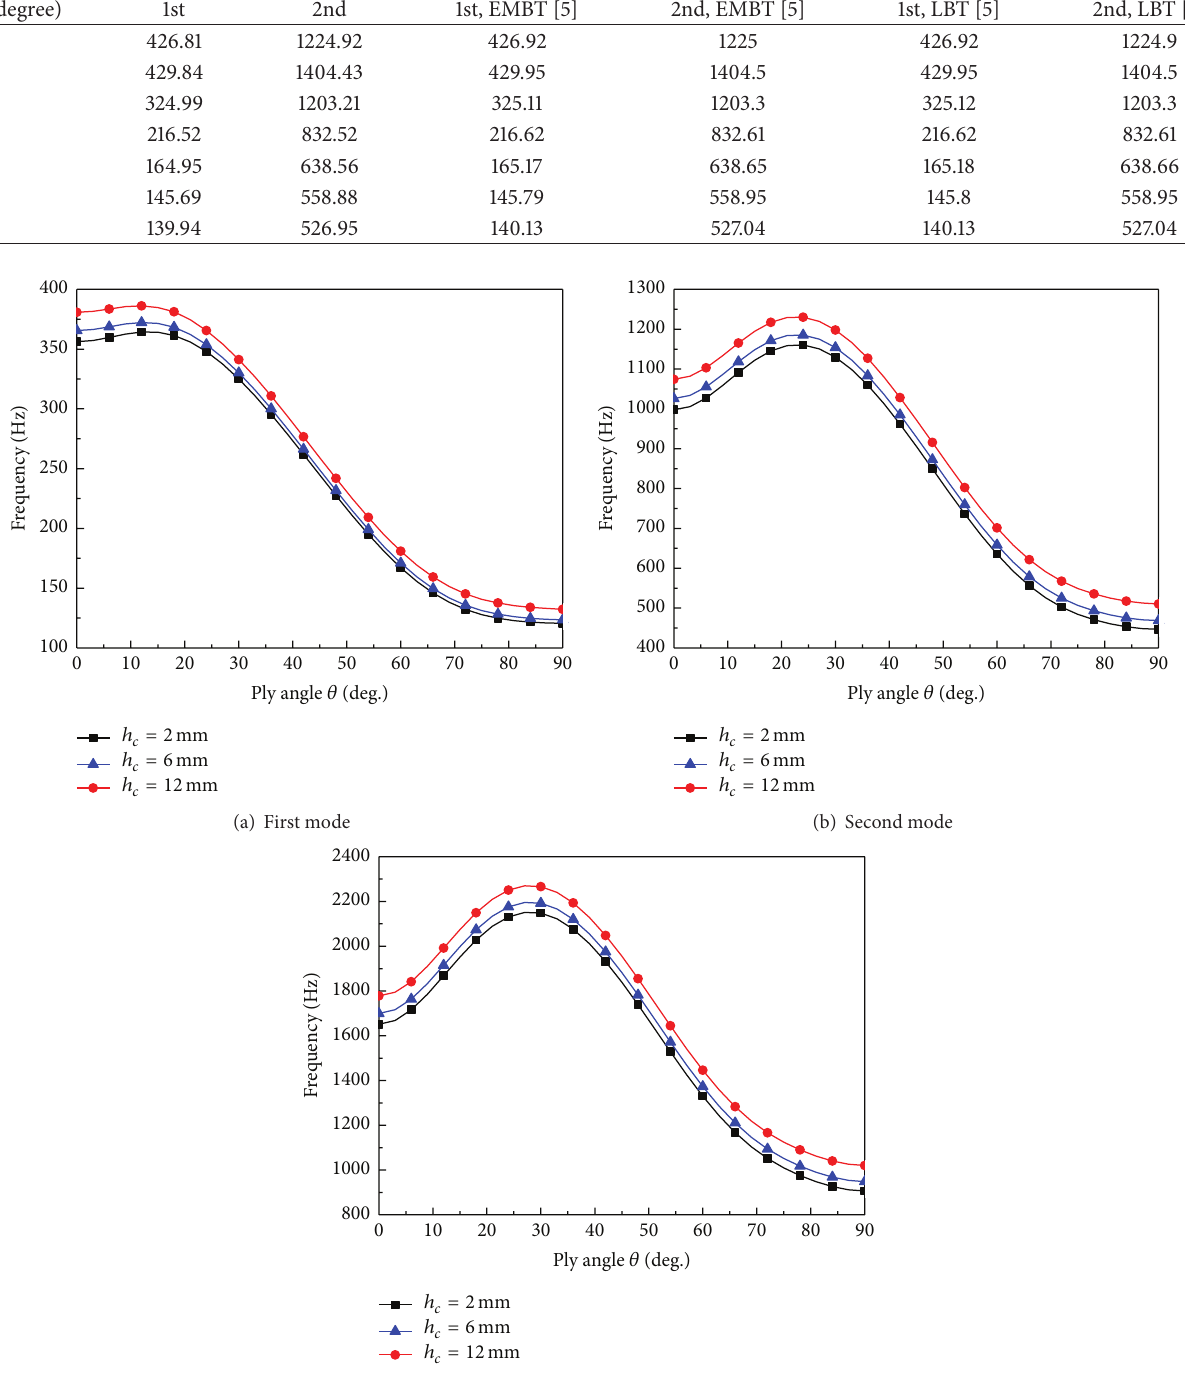
Table 2: Comparison of natural frequencies (Hz) for composite thin-walled tube.